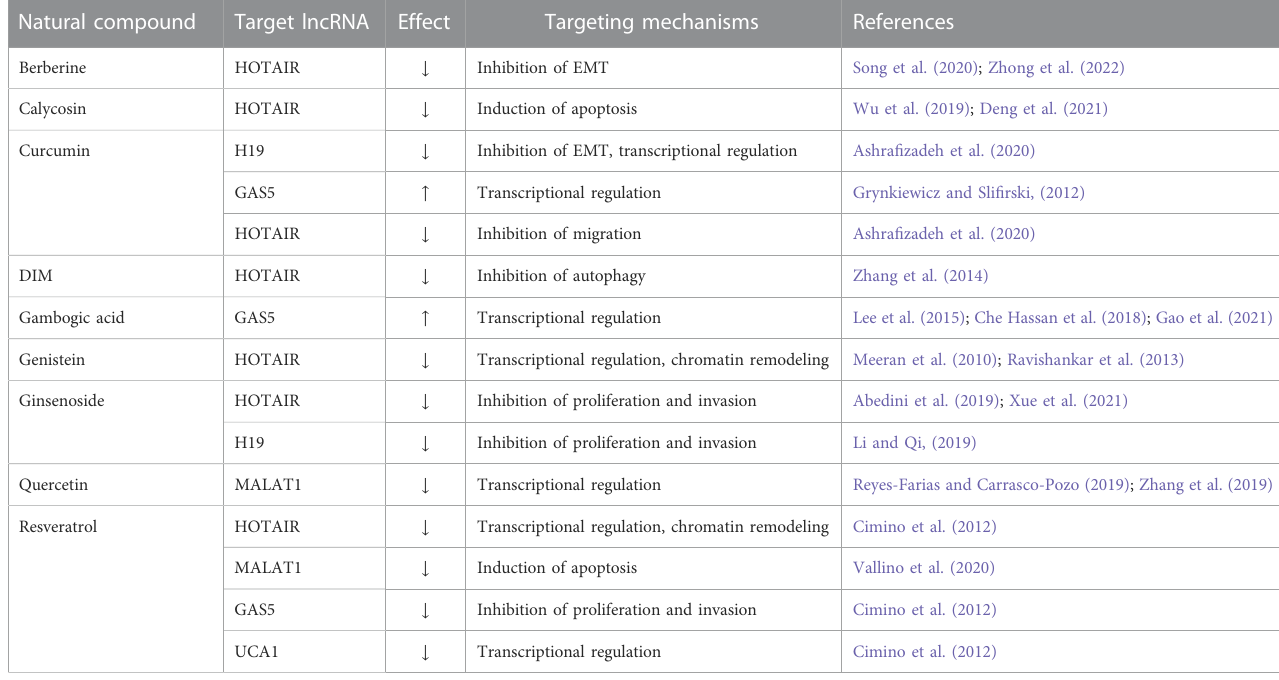
TABLE 2 Regulation of lncRNA by natural products in CRC. Natural